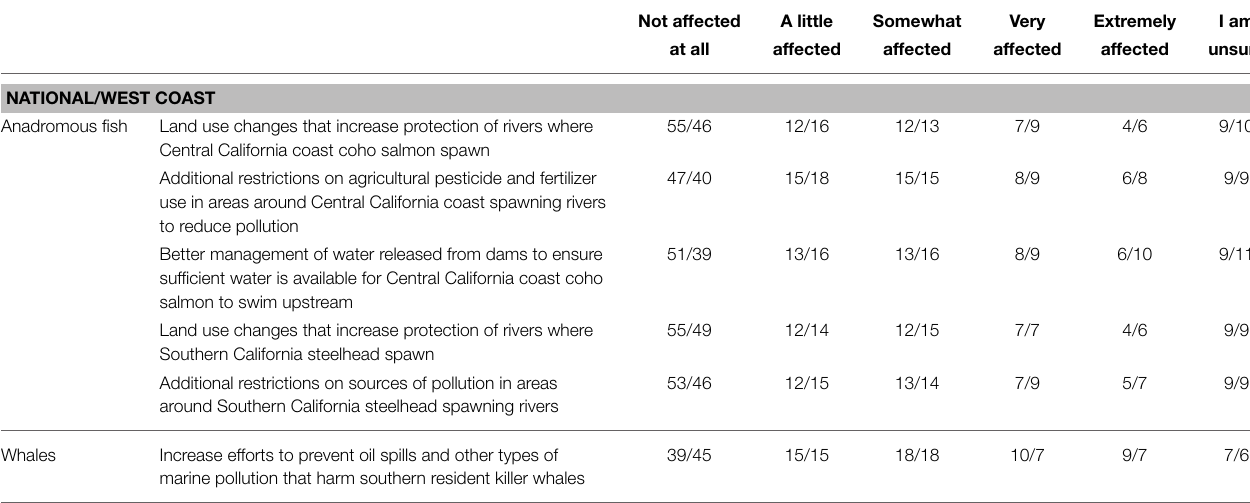
TABLE 4 | Species protection measures that differ * between national and west coast